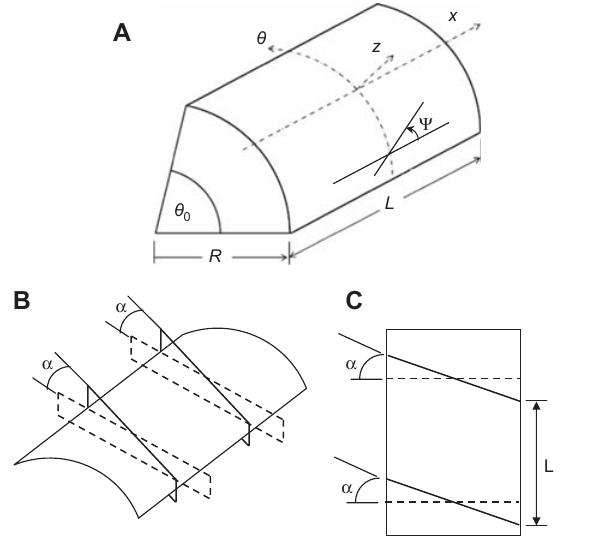
Figure 1 Three dimensional skew open cylindrical